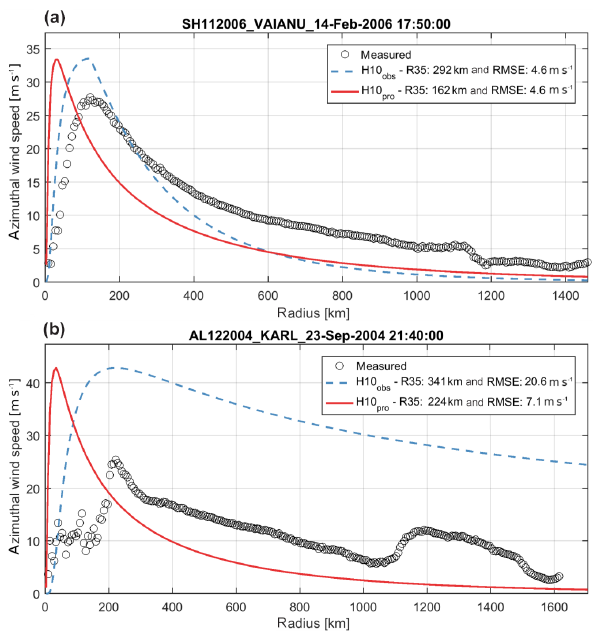
Figure 8. Radial wind profiles for measured wind speeds (black cir- cles), computed wind speeds based on relationships for wind radii (red lines) and computed based on observed wind radii for tropi- cal cyclones Vaianu (14 February 2006) (a) and Karl (23 Septem- ber 2004) (b) . Measured data are based on QSCAT-R data, while computed values are based on the H10 wind profile calibrated with the relationships proposed in this paper (red line) or observed data (blue line). Panels (a) and (b) are examples indicating when a dif- ference between measured wind speeds and TC size can be encoun-